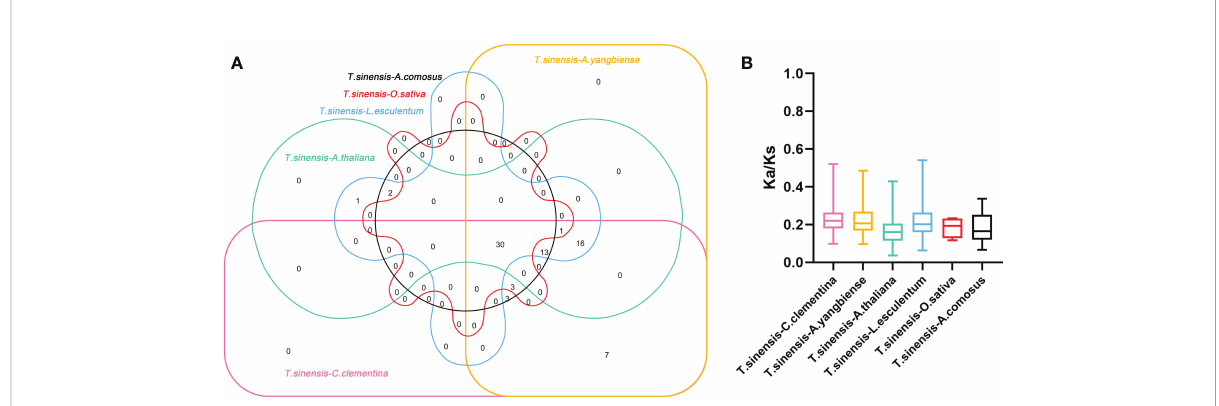
FIGURE 7 Non-redundant syntenic and evolution analysis of the WRKY gene families in a diversity of species. (A) The Venn diagram depicts syntenic WRKY genes found in multiple species. (B) The ratio of nonsynonymous to synonymous substitutions (Ka/Ks) of WRKY genes in T. sinensis and other six species: Citrus clementina (C. clementina) , Acer yangbiense (A. yangbiense) , Arabidopsis thaliana (A. thaliana) , Lycopersicon esculentum (L. esculentum) , Oryza sativa (O. sativa) , and Ananas comosus (A. comosus)